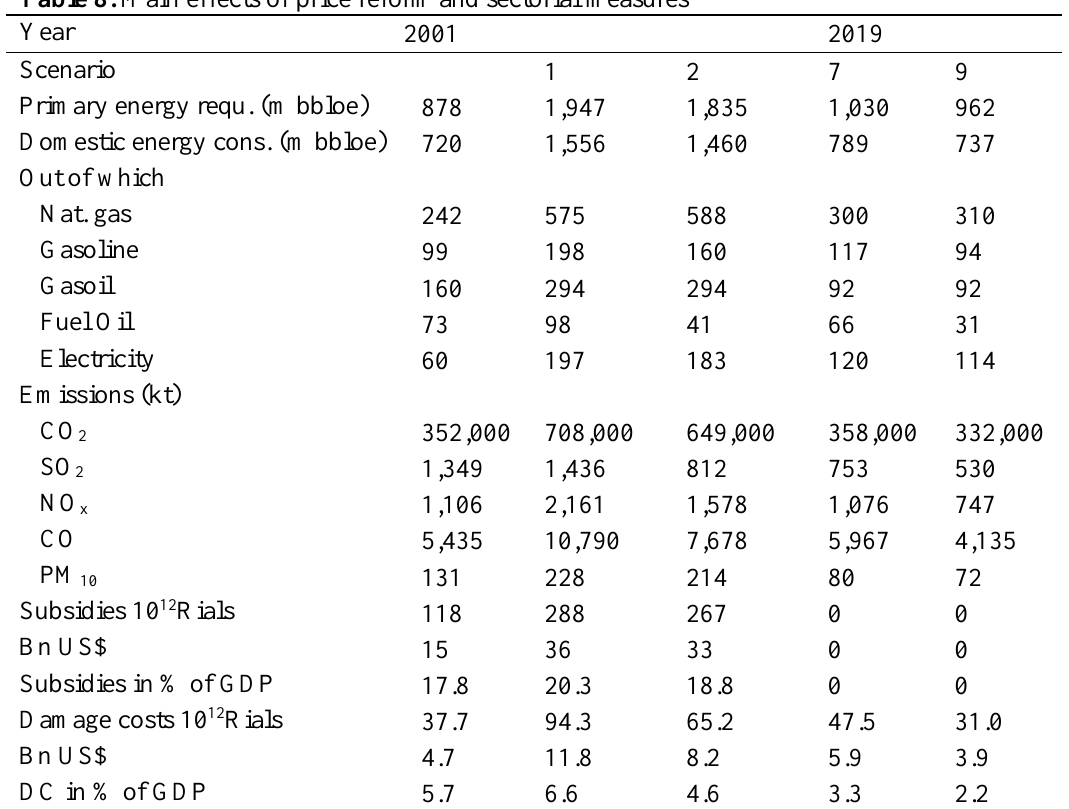
Table 8. Main effects of price reform and sectorial